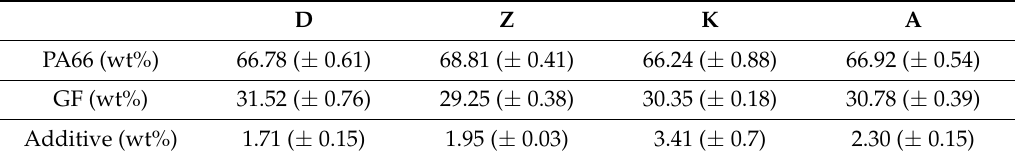
Table 1. The composition of glass fiber 30% filled